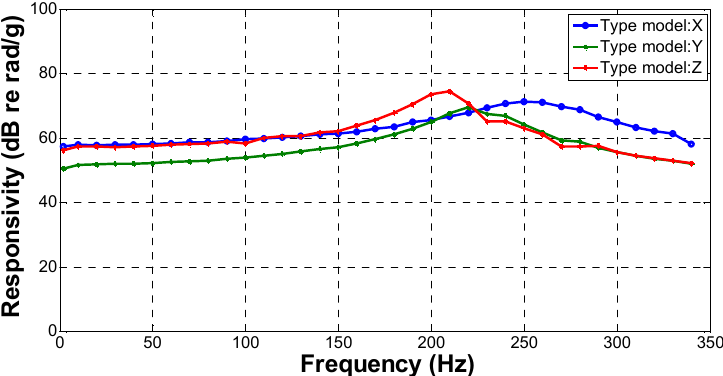
Figure 9. Responsibility test results for the three orthogonal geophones.